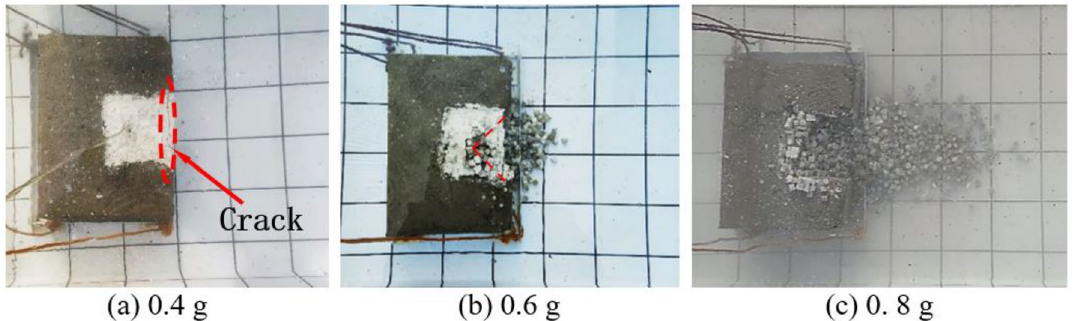
Figure 8. Accumulation of block particles in underwater bench blasting under different